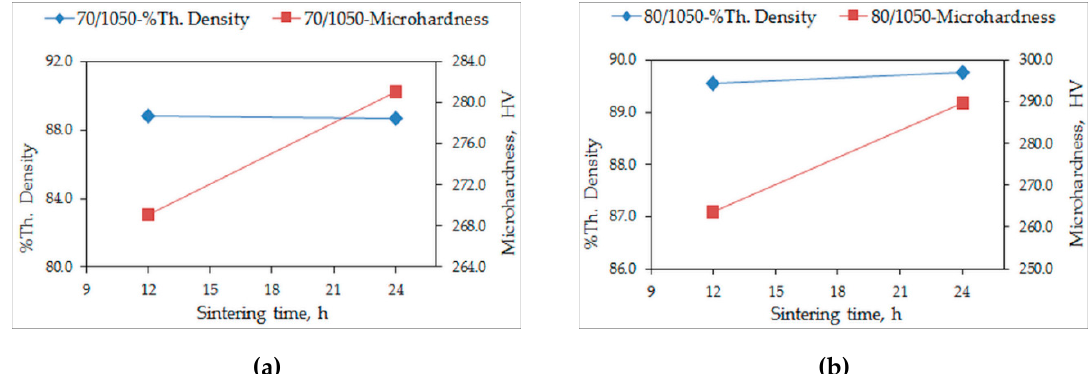
Figure 2. Variation of % theoretical density and microhardness with sintering time of: ( a ) S1050a1, S1050a2 and ( b ) S1050b1, S1050b2.